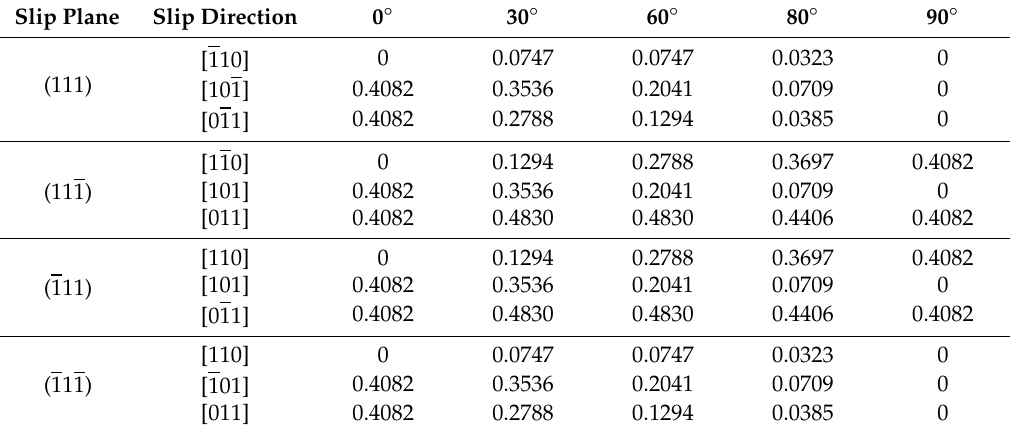
Table 2. Schmid factors of di ff erent slip systems under di ff erent misorientations in the Ni 3 Al layer. Slip